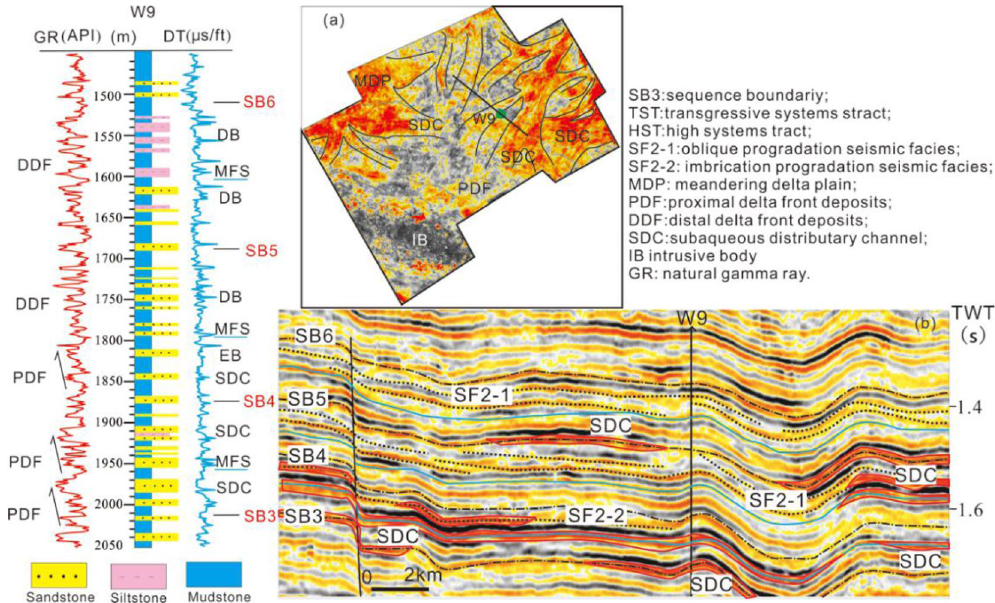
Figure 7. 3D seismic root mean square amplitude slice of the Highstand systems tract of meandering river delta systems in S4 ( a ) and an interpreted seismic profile calibrated to borehole W9 showing the deposits of the meandering river delta front from S3 to S5 in the Enping Sag ( b ). The subaqueous distributary channels were divided into three branches on the plane and superimposed vertically on the seismic profile, with a thickness of 3–5 m.